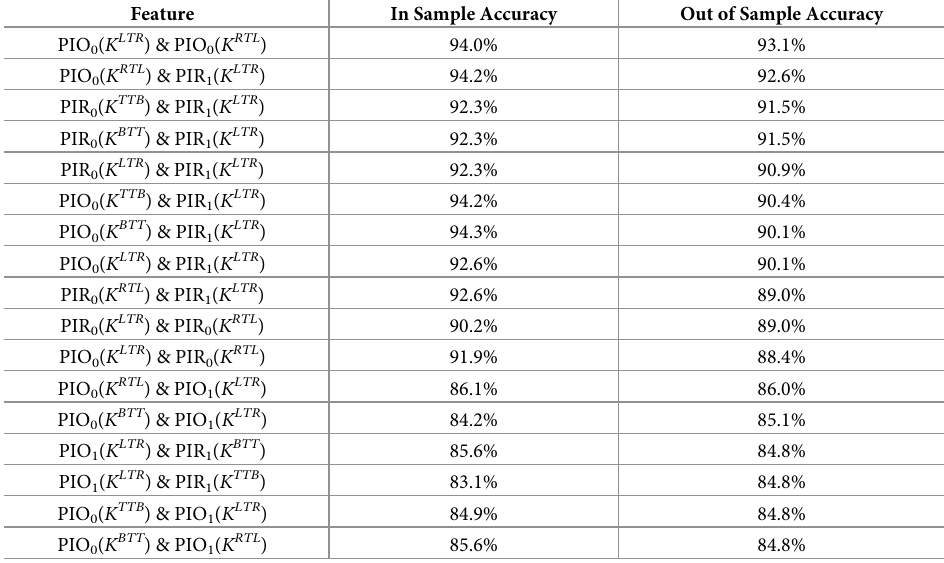
Table 1. Summary of the 15 sweeping plane double descriptor vectors that achieved the highest OOS accuracy